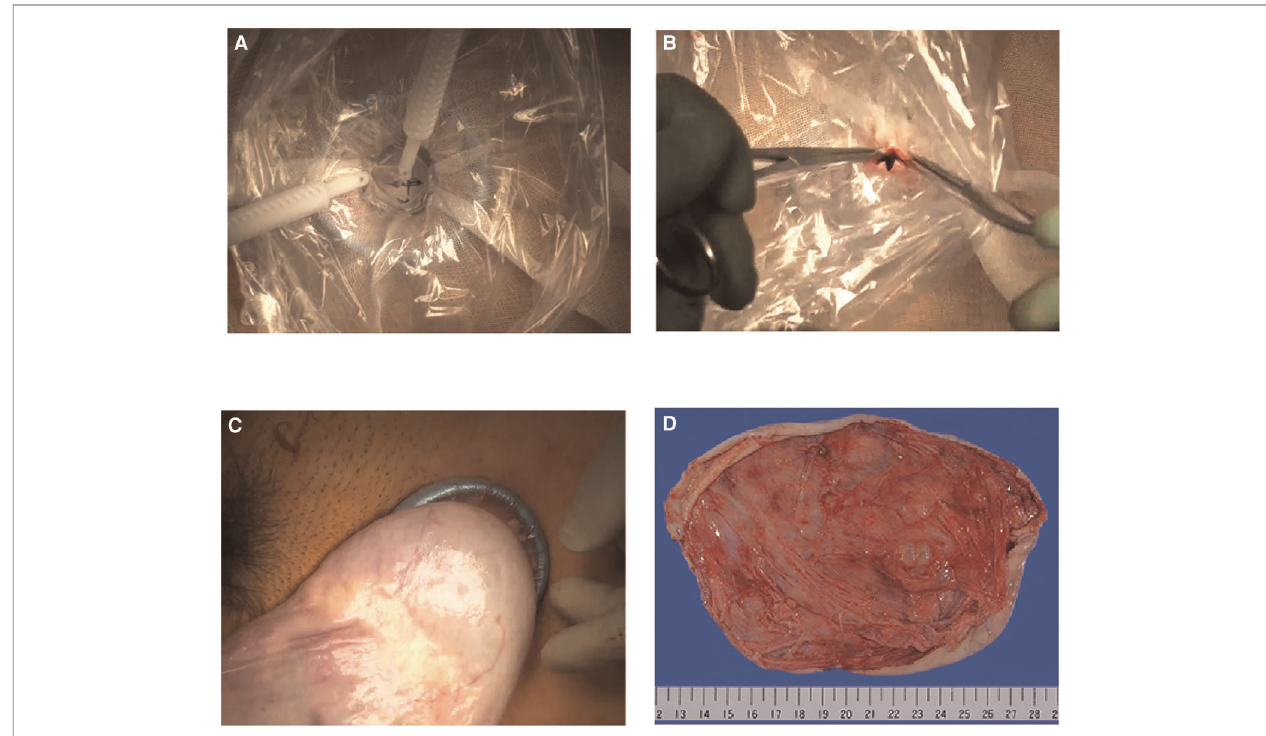
FIGURE 3 | Aspiration of the cyst fl uid and cystectomy of the giant ovarian cyst. ( A ) Aspirating cyst fl uid over the wrap. The cyst fl uid of the serous cystadenoma fl ows from the puncture hole. ( B ) After cyst fl uid aspiration, the mounting is pinched off with forceps to avoid intraperitoneal spillage of the cyst fl uid. ( C ) The cyst is brought outside the body. ( D ) Resected giant ovarian cyst. The longitudinal diameter of the cyst is 205 mm. The pathological diagnosis was serous